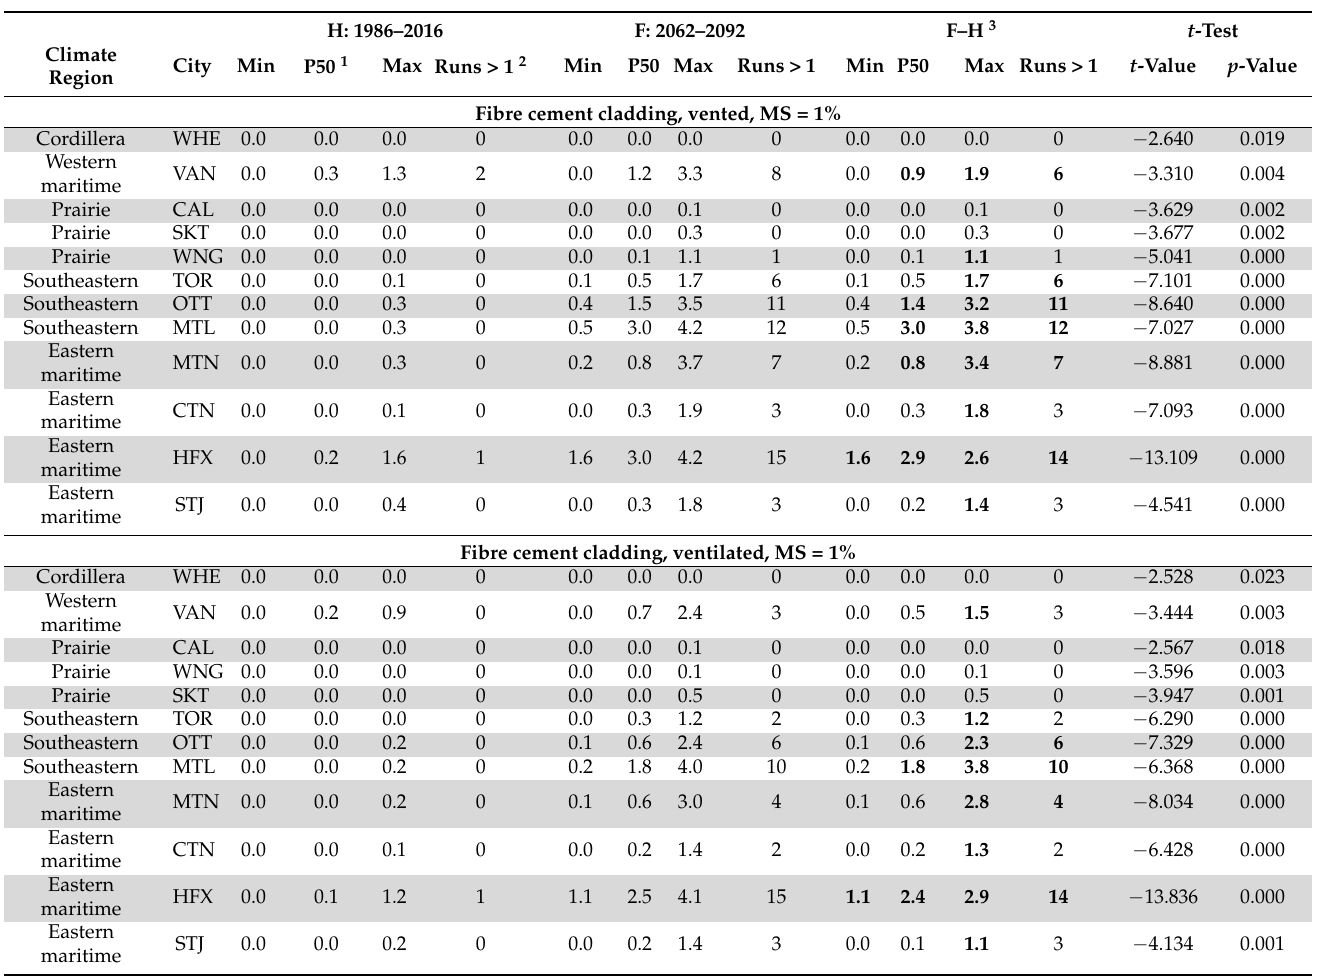
Table 4. Summary statistics and projected changes in mold growth index in the case of fiber cement cladding with a moisture source of